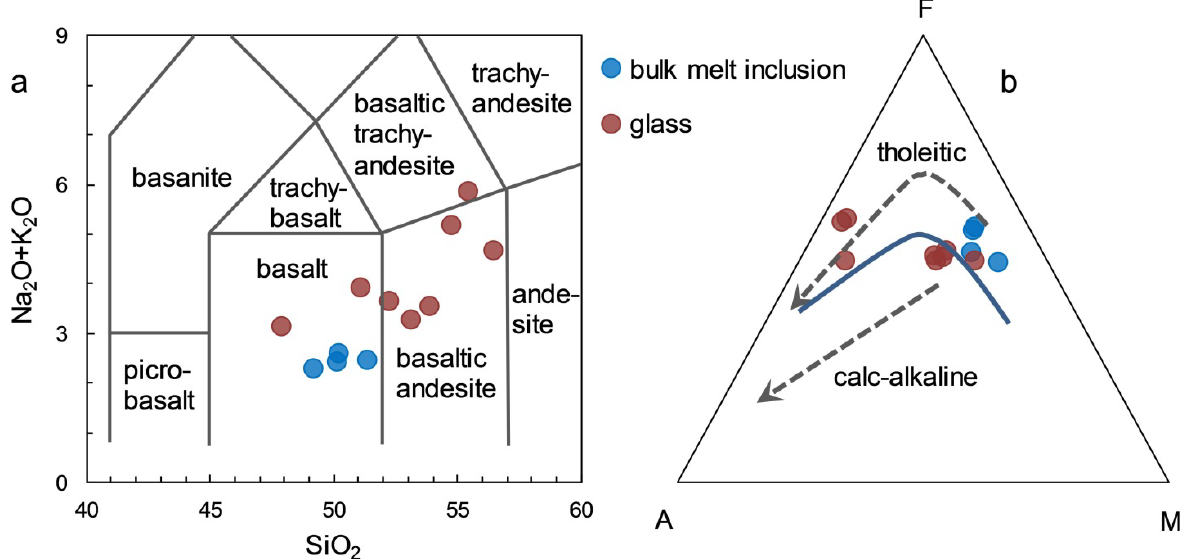
Figure 17. Classification diagrams for melt inclusions captured by chromian spinels from the Sabanuy paleoplacer: ( a )—TAS (wt.%), after [101], ( b )—AFM (wt.%), after [102].